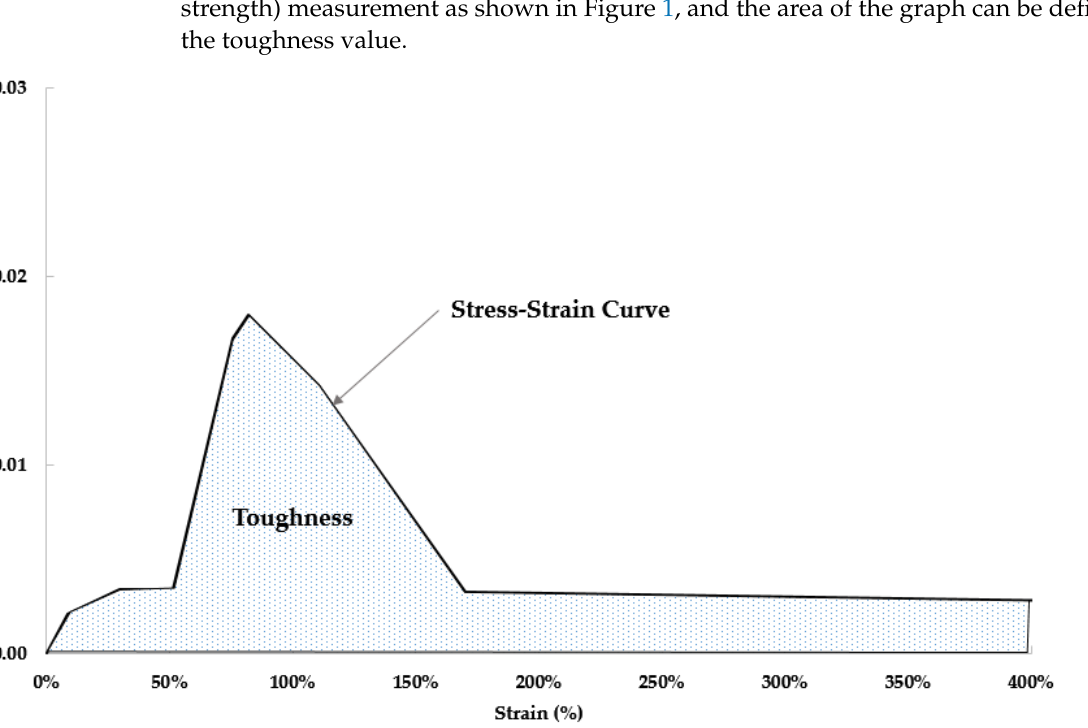
Figure 1 . Toughness in the stress-strain curve of SPRG [8] . Figure 1. Toughness in the stress-strain curve of SPRG